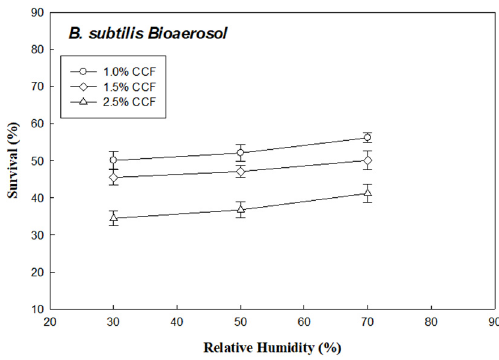
Figure 6. Survival of B. subtilis bioaerosols through the chitosan-coated and untreated filters in different relative humidity.